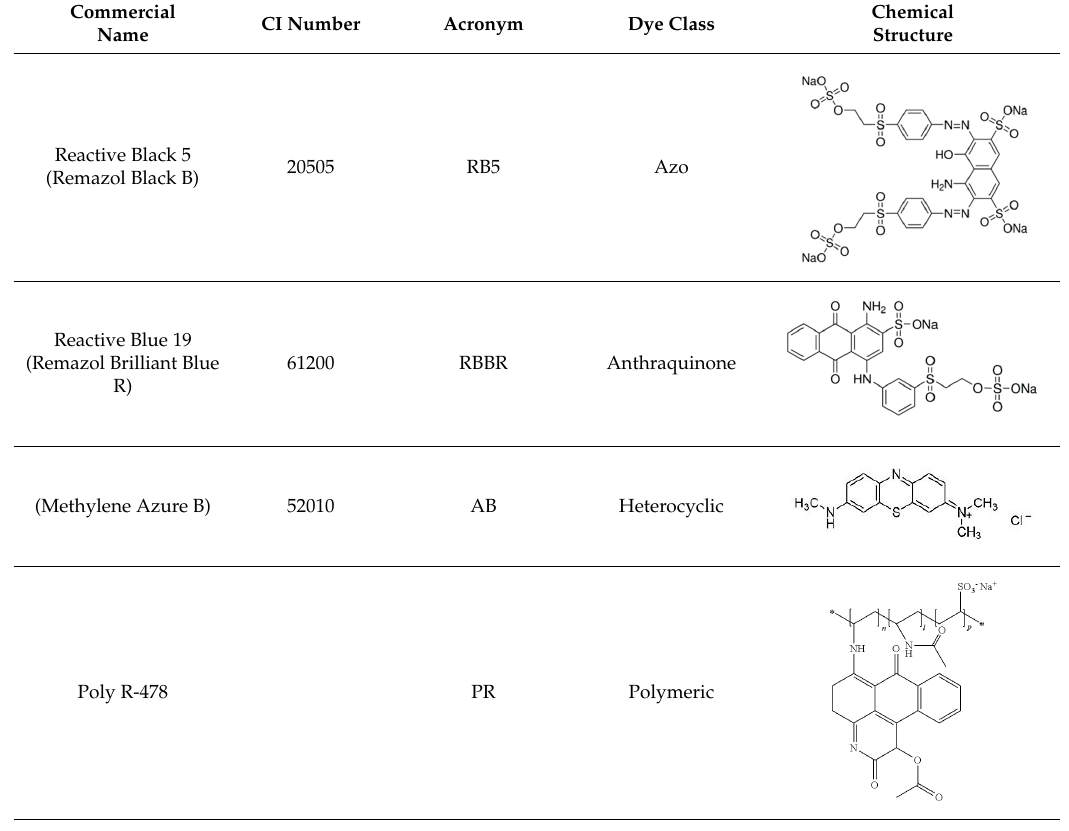
Table 2. Solid-plate dye decolorization in Bran Flakes (BF) medium supplemented with 200 ppm of each of the dyes evaluated.